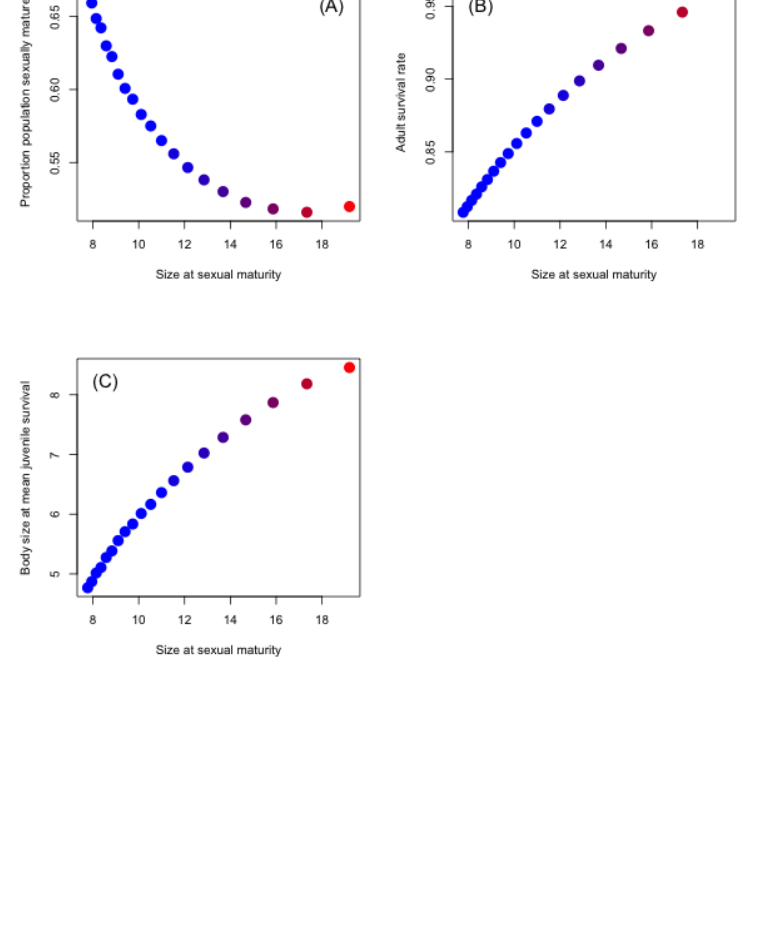
Figure S1. Associations between size at sexual maturity and each of the terms in our approximation of carrying capacity for the density-dependent juvenile survival scenario. Size at sexual maturity and (A) proportion of the population that is sexually mature, (B) adult survival and (C) body size of juveniles that predicts mean juvenile survival across the distribution of juvenile